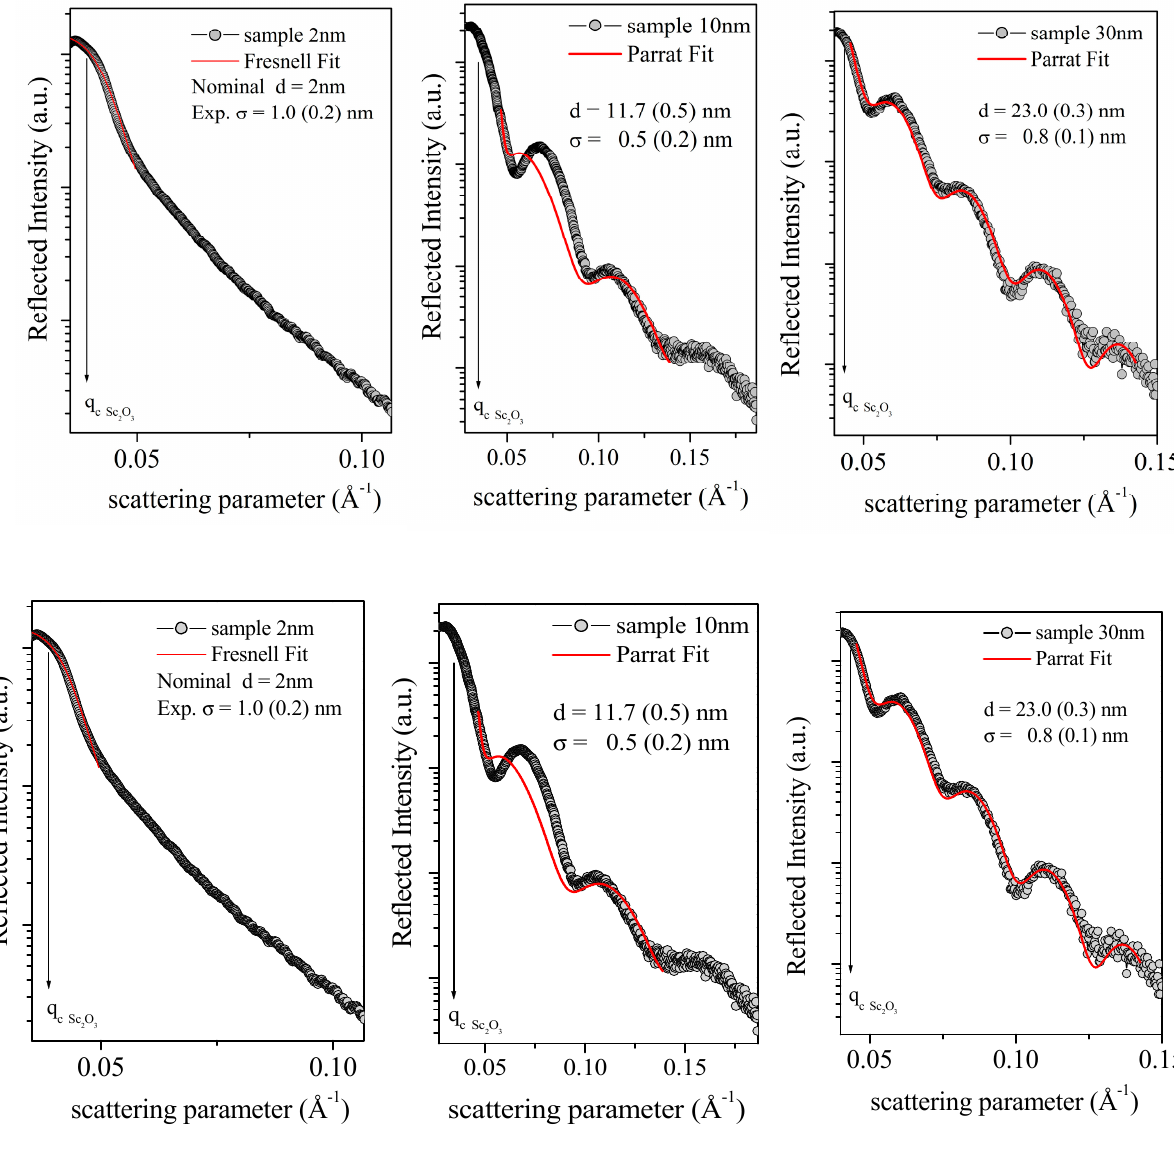
Figure 8. EDXR pa tt erns (black dots) and their fi tt ings (red line) of the samples SCO-2, SCO-10, and Figure 8. EDXR patterns (black dots) and their fittings (red line) of the samples SCO-2, SCO-10, and SCO-30. Black arrows indicate the critical scattering value for each SCO-30. Black arrows indicate the critical sca tt ering value for each sample.